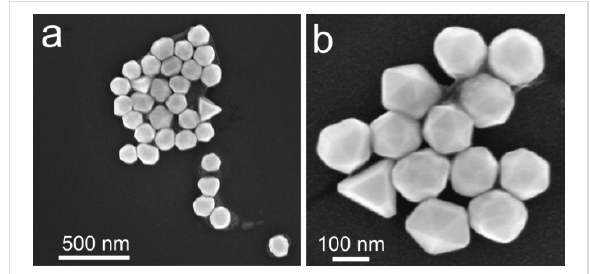
Figure 2: High resolution SEM images of Au NPs (150 nm) of different shape as deposited from a solution.